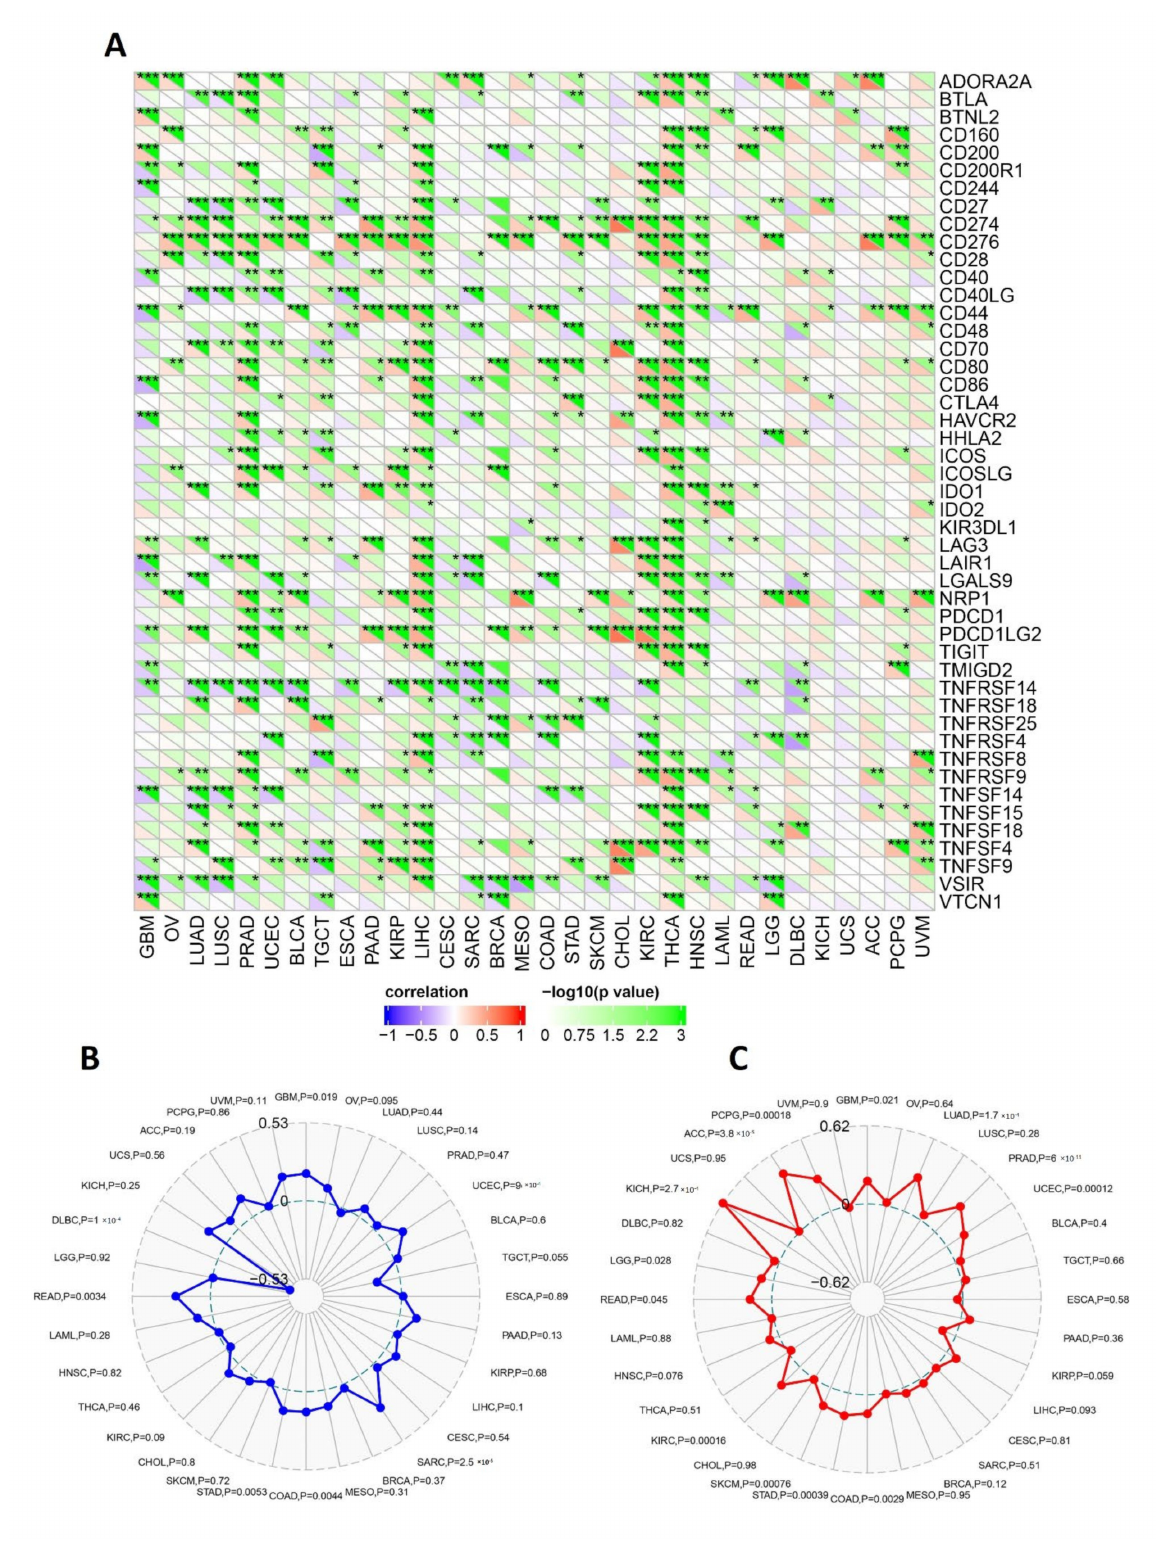
Figure 8. Correlations of RACGAP1 expression with immune checkpoints, MSI, and